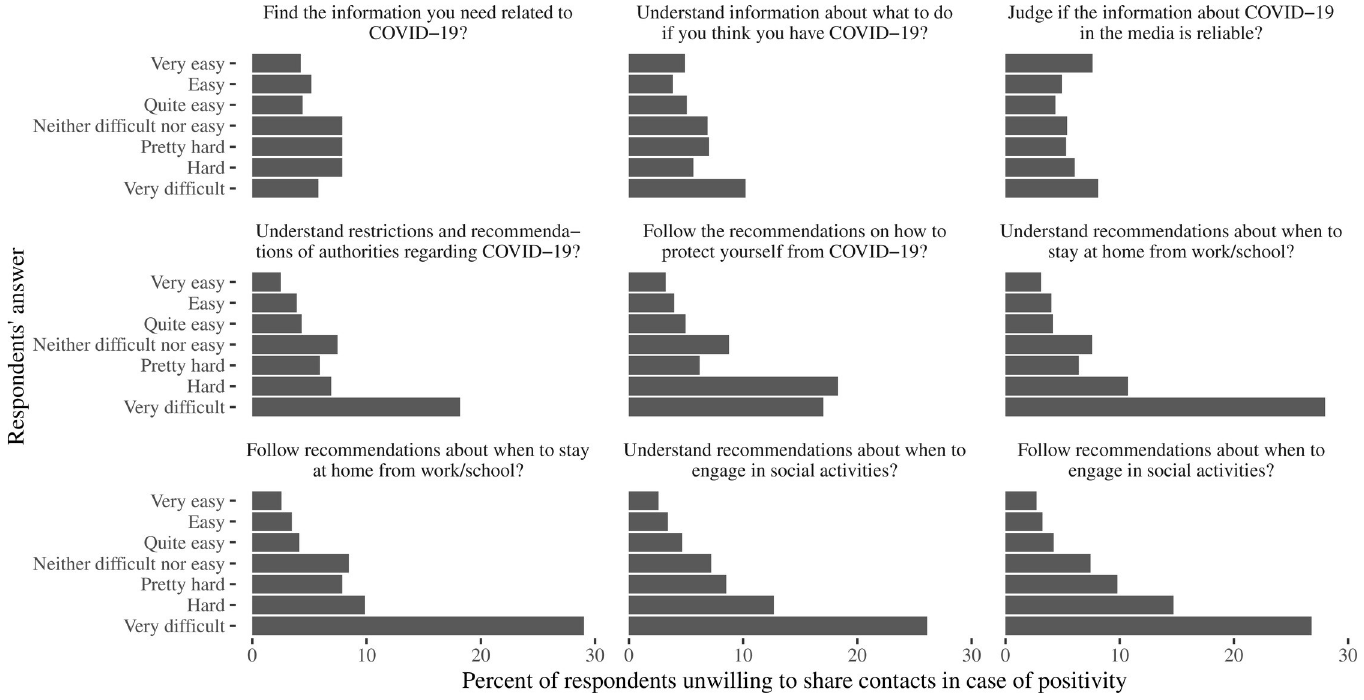
Fig 2. Percent of respondents who expressed unwillingness to share contacts in case of positivity, according to their response to the questions “How easy or hard it was to ... ”. The questions are named at each panel on the figure.